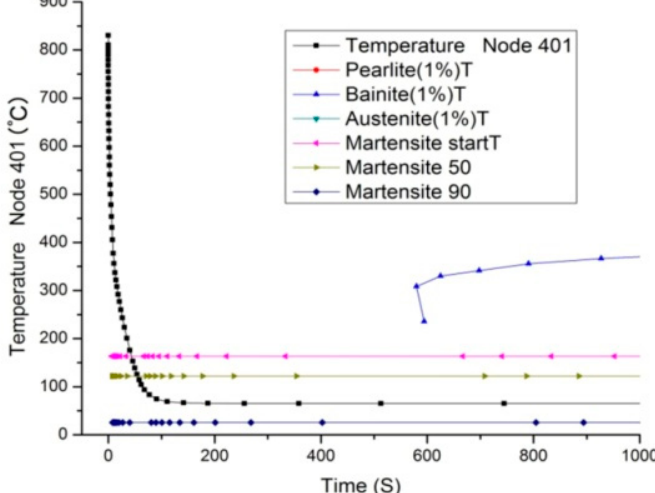
Figure 12. Cooling curve of the surface with CCT.